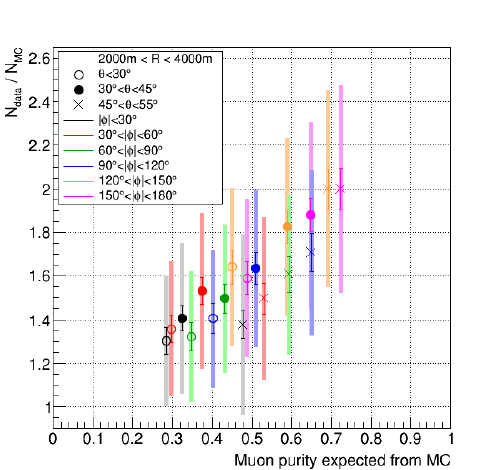
Figure 12. Data / MC ratio of signal size as a function of R for di ff erent geometrical conditions. (Figure from